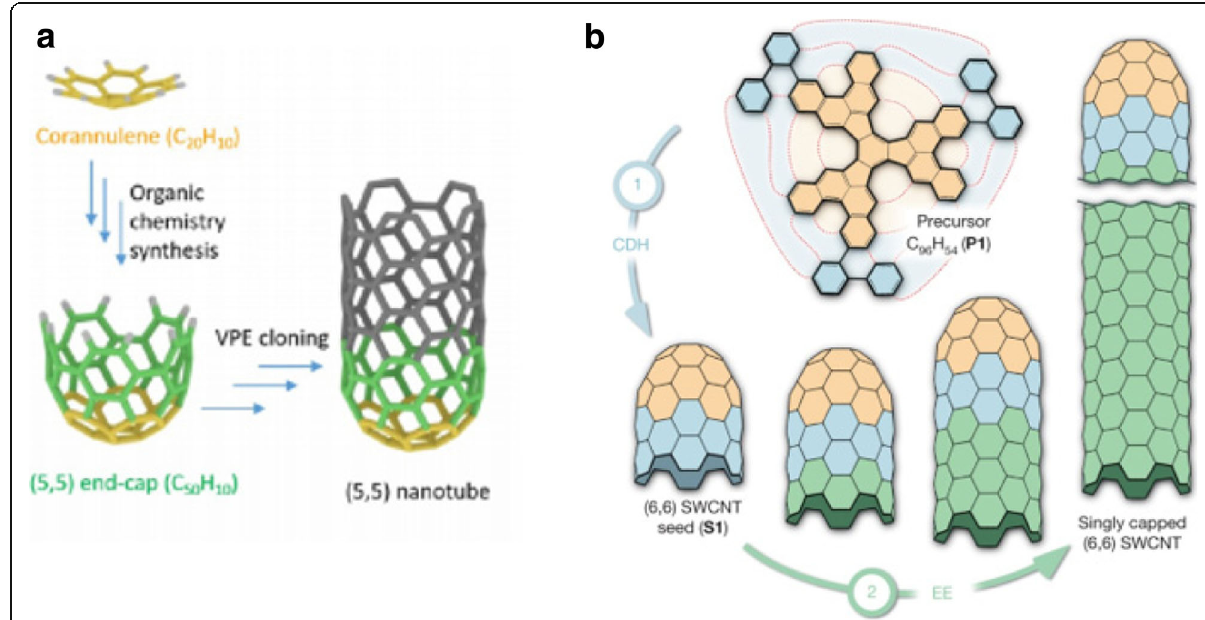
Fig. 12 a Structure molecular end-caps used for chirality controlled synthesis of (5,5) SWCNTs through VPE elongation that was free of metals. Adapted from [130]. b Schematic illustration of a two-step bottom-up synthesis of SWCNTs from molecular end-cap precursors. Singly capped ultrashort (6,6) seeds lead to epitaxial elongation of nanotubes using the carbon atoms originating from the surface-catalysed decomposition of a carbon feedstock gas. Adapted from